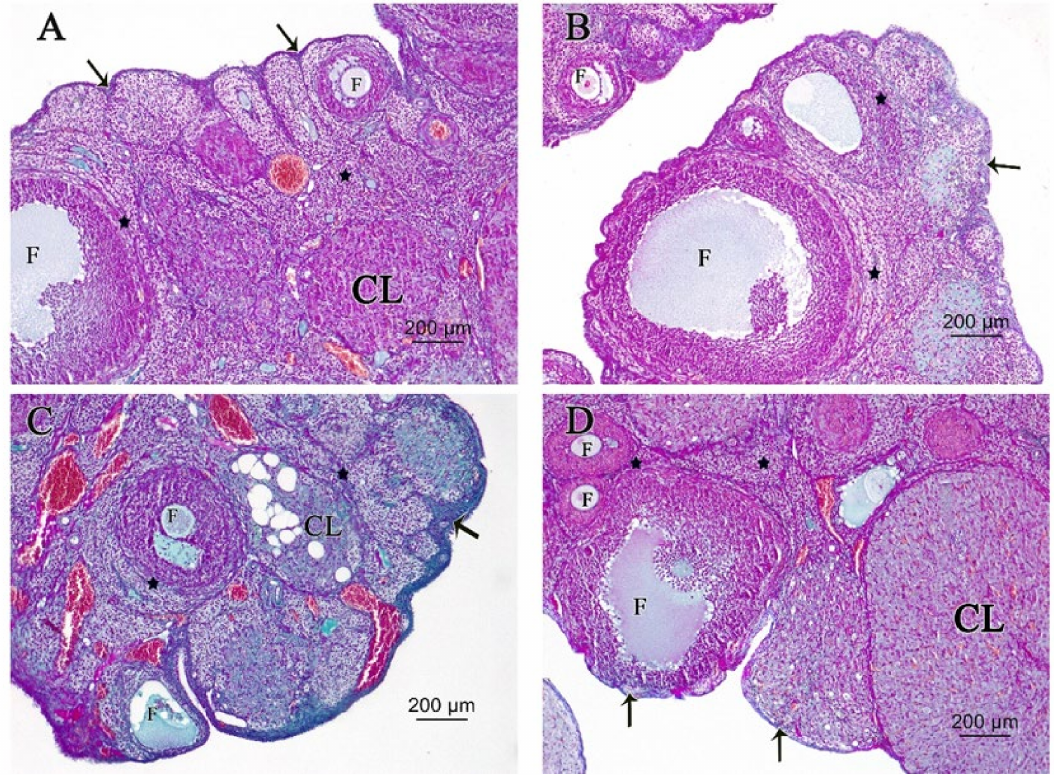
Figure 6. Photomicrographs of (MT × 100) stained ovarian sections. ( A ) Control group and ( B ) mela- tonin group showing normal deposition of delicate collagen fibers in tunica albuginea (arrow) and stroma (star) around and in between follicles (F). ( C ) Cisplatin-treated group showed increased deposition of collagenous fibers in tunica albuginea (arrow) and the stroma (star) between follicles (F) and Corpus Luteum (CL). ( D ) Cisplatin + melatonin-treated group showed normal deposition of delicate collagen fibers in tunica albuginea (arrow) and the stroma (star) around and in between follicles (F) and Corpus Luteum